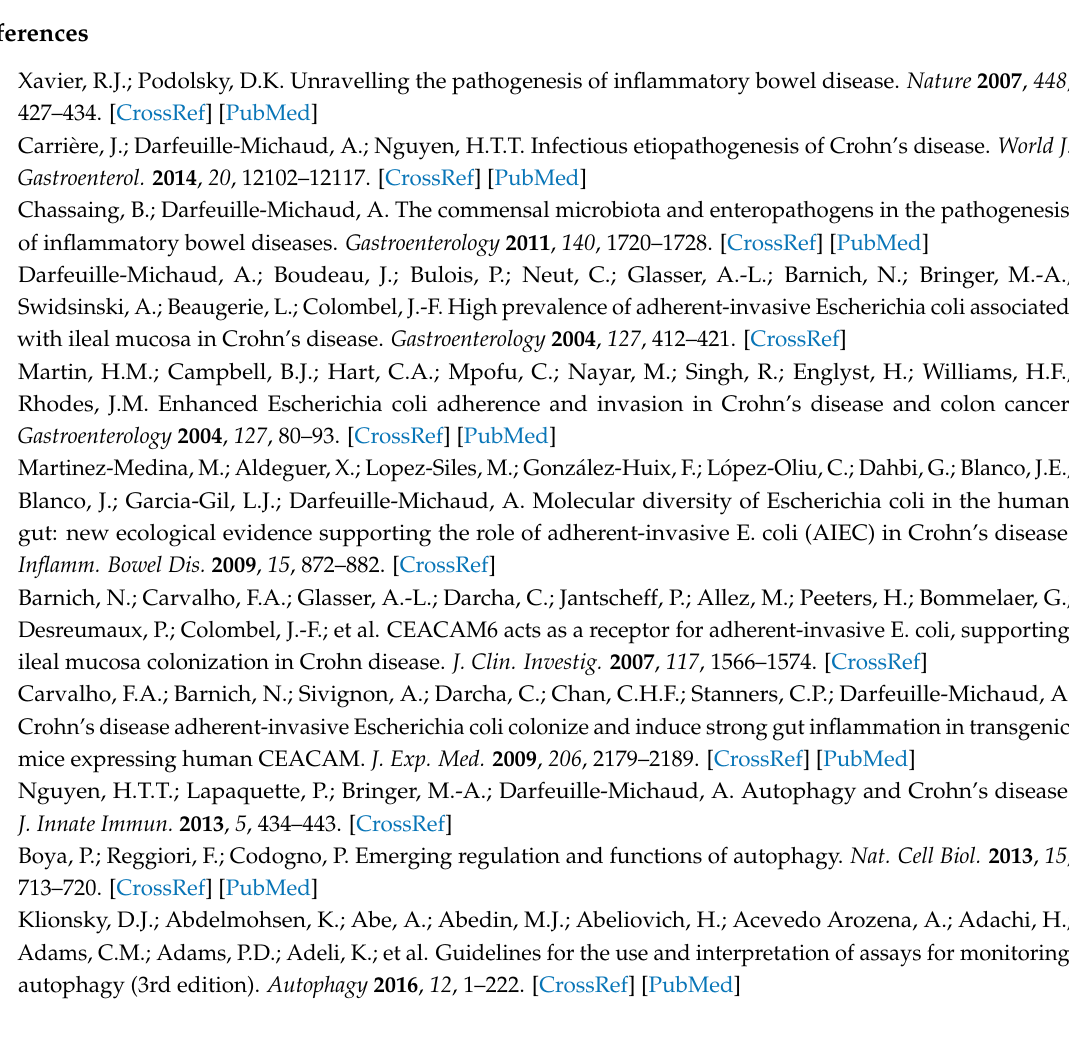
Table S1: Primers used in this